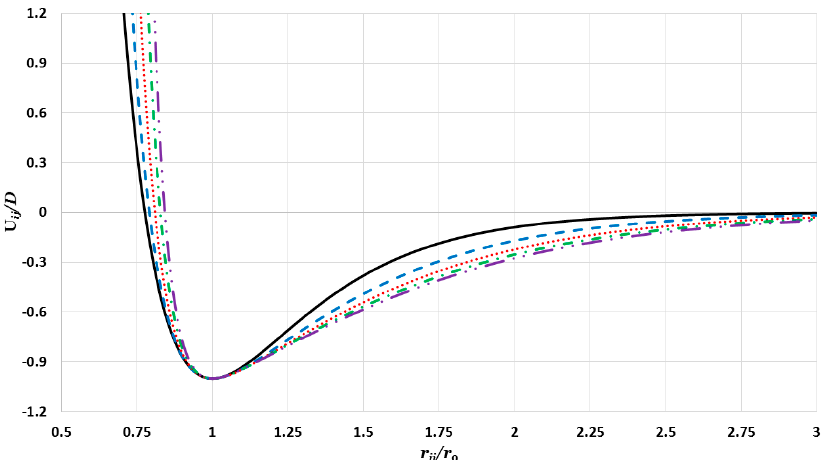
Figure 13. Generalized Morse potential curves for di ff erent values of m and α , where the black solid line represents m = 1 and α = 3.1 (Morse potential function [13]), the blue dashed line represents m = 2 and α = 2.4, the red dotted line represents m = 3 and α = 2.1, the green dashed-dotted line represents m = 4 and α = 1.95, and the purple long dashed-dotted-dotted line represents m = 5 and α = 1.85 .